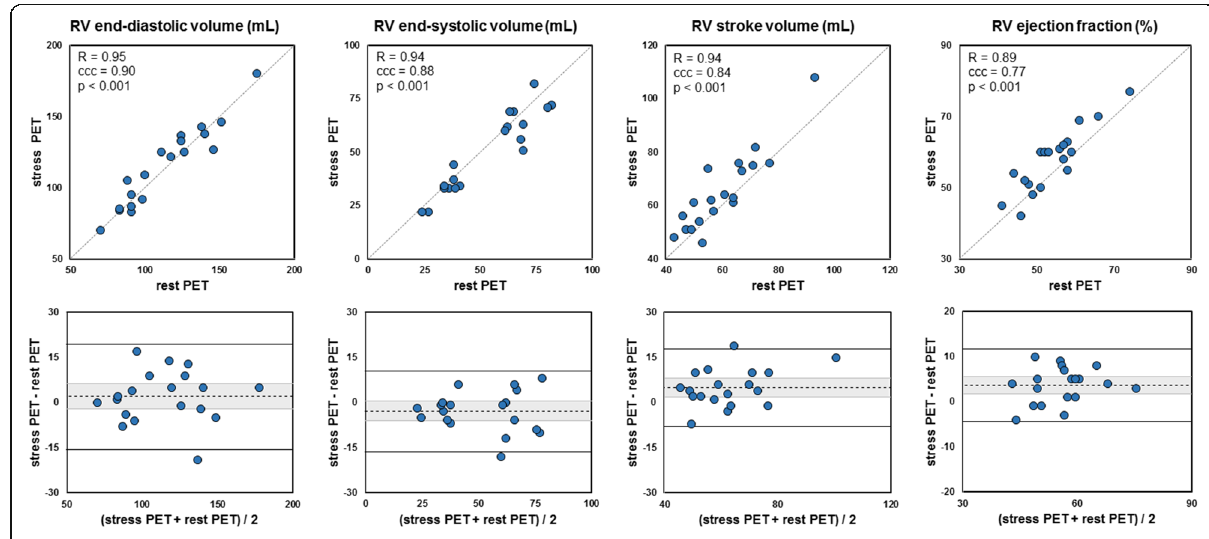
Fig. 2 Comparison between rest and stress right ventricular volumes and function. Top: scatter plots. The grey lines stand for the perfect identity ( R , Pearson ’ s correlation; ccc, Lin ’ s concordance correlation coefficient). Bottom: Bland-Altman diagrams. The dashed lines indicate the mean difference (greyed is the 95% confidence interval) and the plain lines the 95% limits of